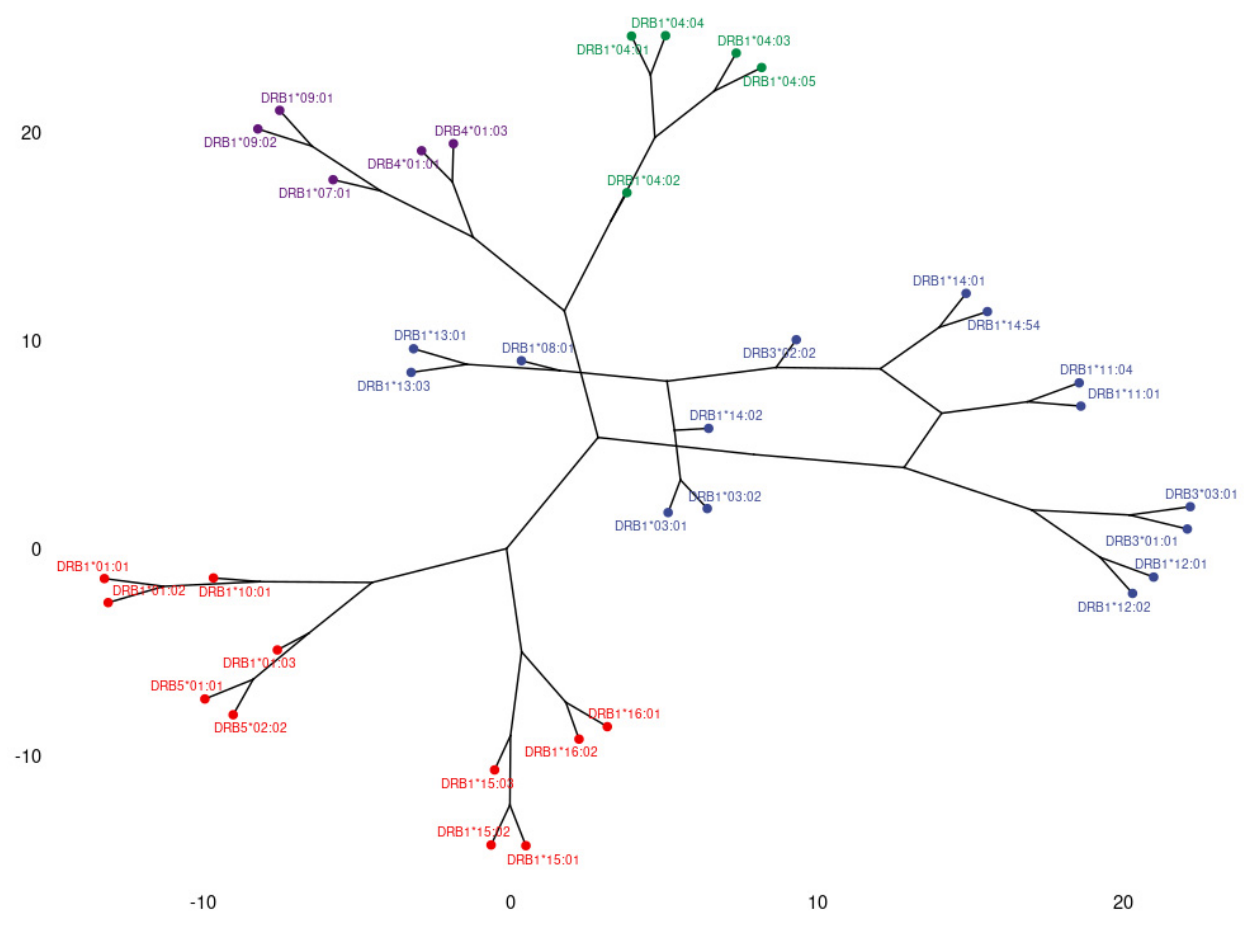
Figure 2. Dendrogram representing anti-HLA-DR response correlations, based on Minkowski dis- tances of antigen specific feature vectors. Three main branches corresponding to distinct groups of responses are observed. Group A, in blue, includes responses against DRB1*03, *11, *12, *13, *14 and DRB3 (DR52), as well as anti-DRB1*08 response, group B (in green and purple) represents responses against DRB1*04, *07, *09 and DRB4 (DR53) and group C (in red) includes responses against DRB1*15, *16 and DRB5 (DR51), as well as anti-DRB1*01 and *10 responses.